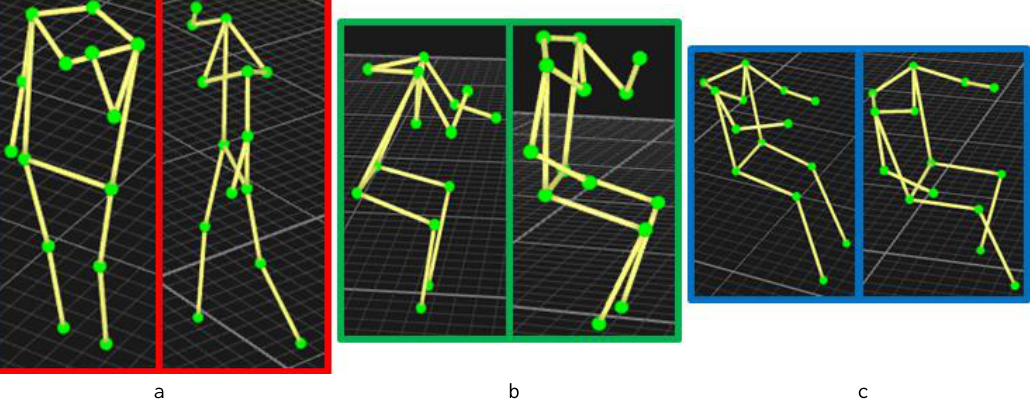
Figure 2. Screenshots of data from the Qualisys motion capture system showing some variations in the way different subjects perform the same activity. ( a ) shows variations in making a cell phone call; ( b ) shows variations in eating; and ( c ) shows variations in